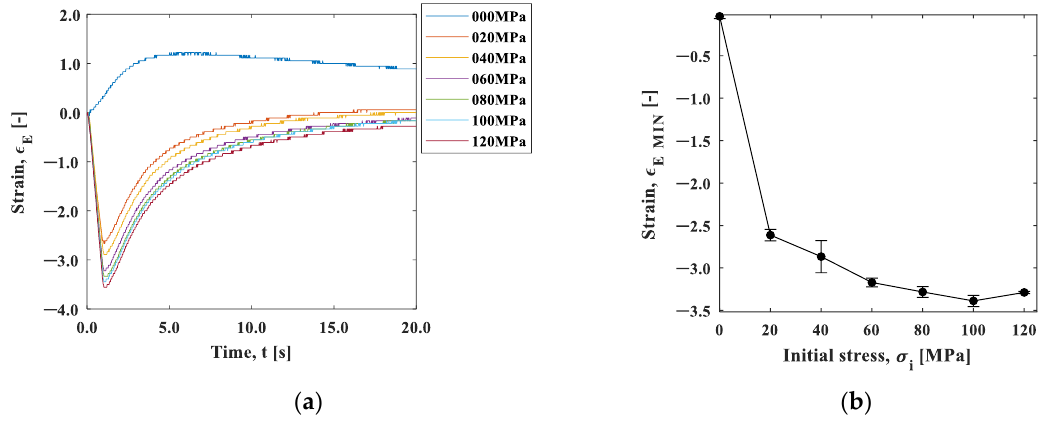
Figure 13. ( a ) Strain – time curve; and ( b ) strain – initial stress curve.